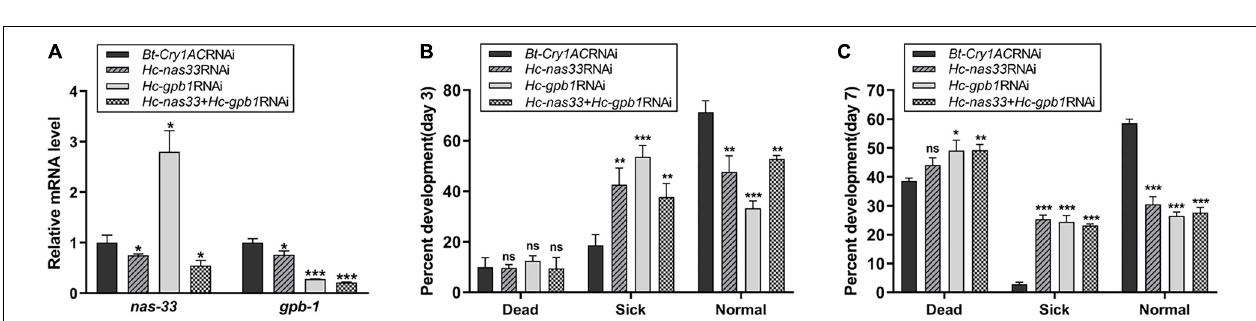
FIGURE 6 | Transmission electron microscopy of nas-33 and gpb-1 RNA interference-treated Haemonchus contortus . (A) Cuticle structure of Bt-Cry1AC RNAi-treated worm. (B) Two layers of cuticles of nas-33 RNAi-treated worm. (C) Loose connection between cuticle and epidermis in gpb-1 RNAi-treated worm. (D) Two layers of cuticles and loose connection between cuticle and epidermis of nas-33 and gpb-1 RNAi-treated worm. L1C, L1 cuticle; L2C, L2 cuticle. Black arrows point to the loose connections between cuticle and epidermis. Scale bar: 0.5 µ m.